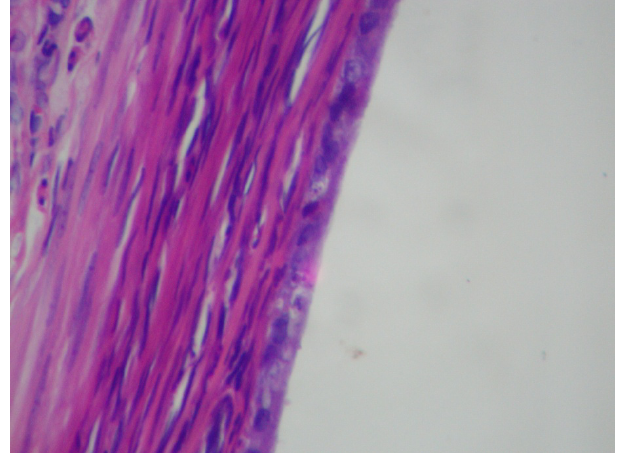
FIGURE 3 - Photomicrography of moderately-preserved epithelium, with mildly-preserved (40X) cytoplasm from the group of rats treated with 0,63 mg/day Copaiferalangsdorffii , administered for a 14-day